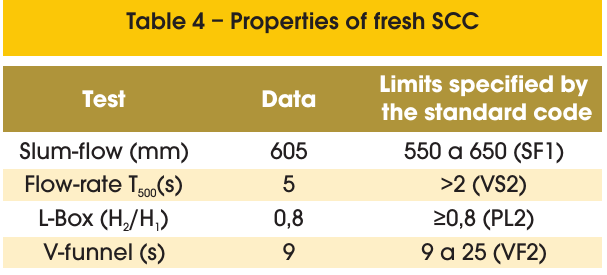
Table 4 – Properties of fresh SCC